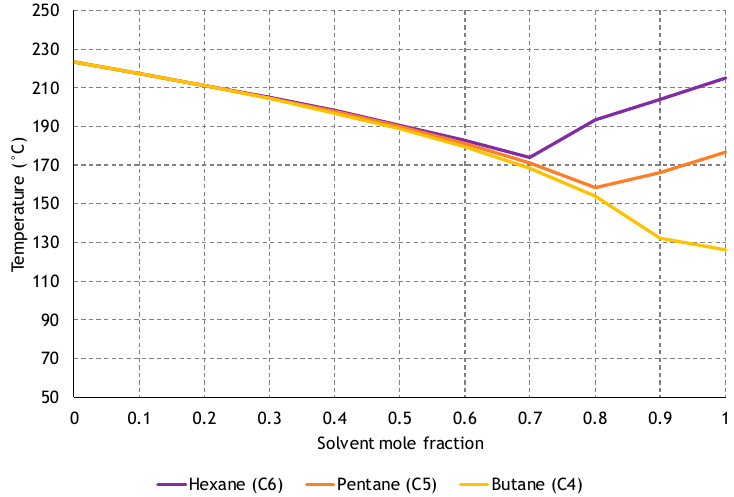
Figure 4. Saturation temperatures depending on solvent concentration for various mixtures of steam and solvent at 2500 kPa (generated by using WinProp (CMG, Computer Modeling Group) [14]).